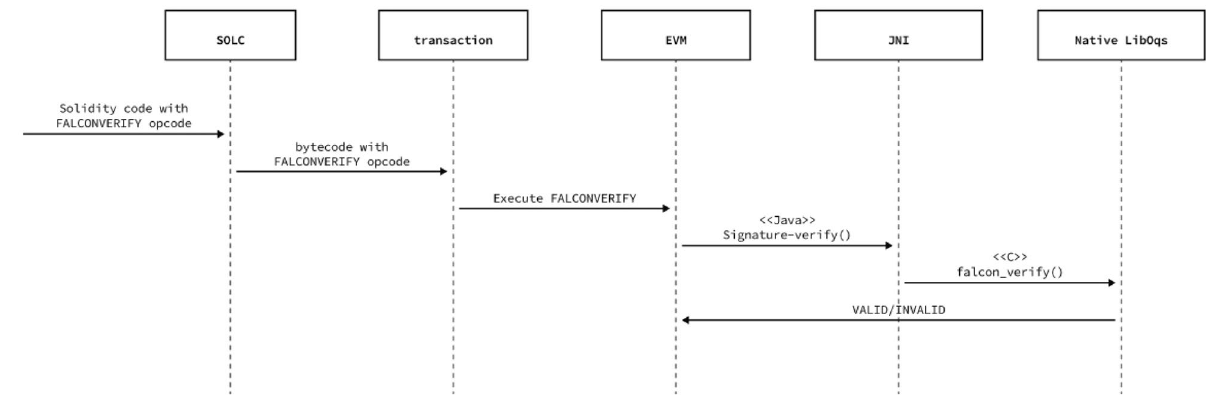
Figure 11. EVM virtual machine-based signature validation